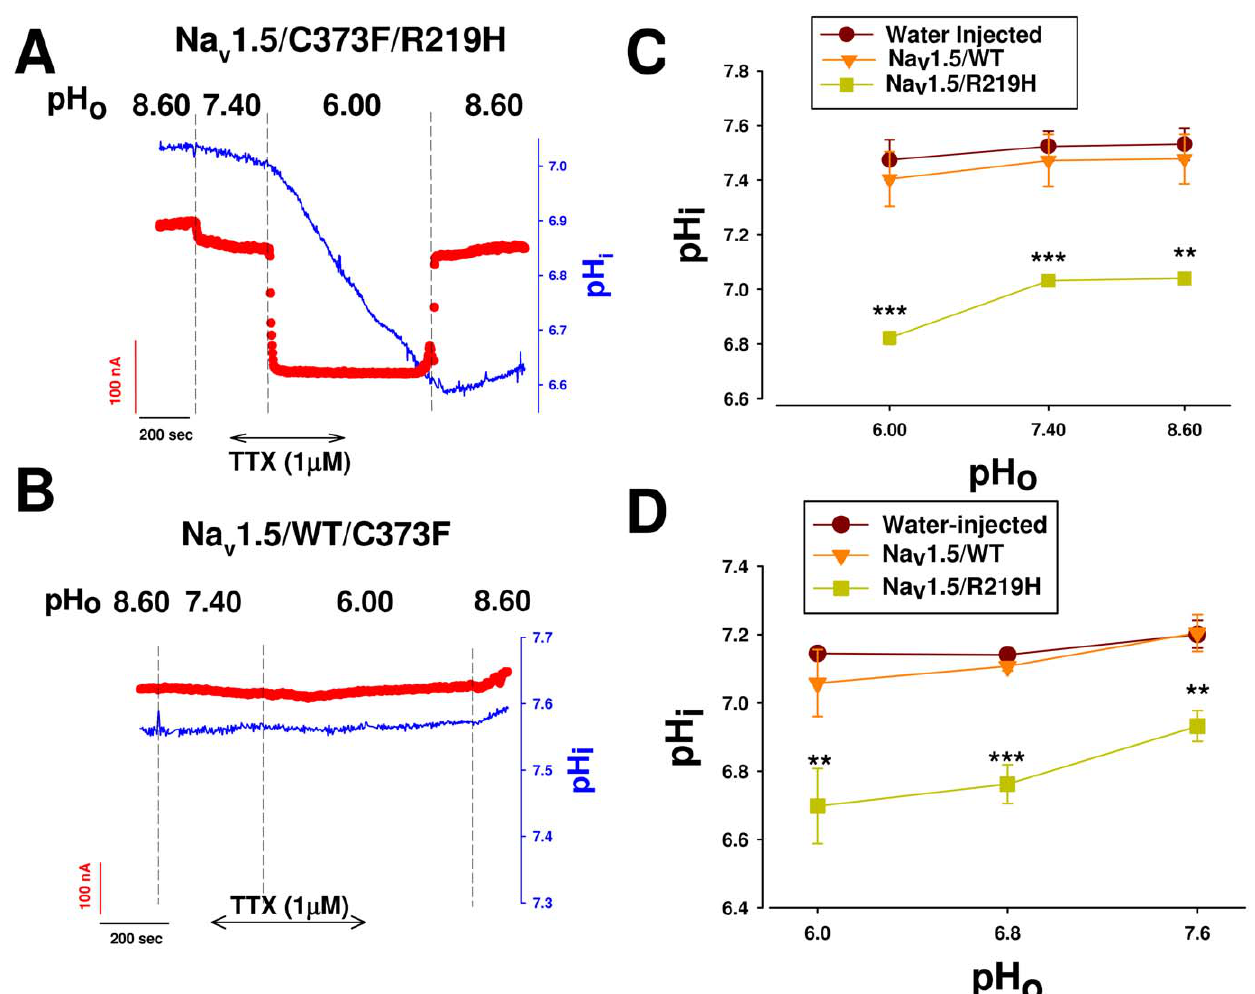
Figure 4. Na v 1.5/R219H induces an inward proton current and intracellular acidification. Xenopus oocytes expressing Na v 1.5/WT or Na v 1.5/R219H channel were impaled with three electrodes, one filled with an H + resin to measure pH i , and two to clamp the oocyte at 2 80 mV in a Na + -free NMDG solution containing 1 m M TTX, as indicated. Typical proton current recordings (red traces) in response to different pH o value and the pH i measurement rate (bleu traces) from an oocyte expressing the Na v 1.5/R219H ( A ) or Na v 1.5/WT channel ( B ). Intracellular pH i values before changing solutions in experiments similar to ( A ) and ( B ) were plotted against pH o (***, p , 0.001 compared to WT, n=10–19)( C ). Similar recordings were obtained with four batches of oocytes. ( D ) Changes in pH i after incubating oocytes expressing the Na v 1.5/WT (triangles) or Na v 1.5/R219H (squares) channel, or water-injected oocytes (circles) in OR3 medium at different pH o values (***, p , 0.001, **; p , 0.01; *, p , 0.05; compared to WT, n=7–13). pH i measurements were carried out in Ringer’s solution at pH o of 7.40.